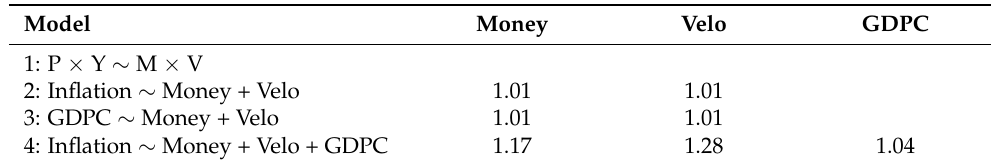
Table 9. Variance inflation factor